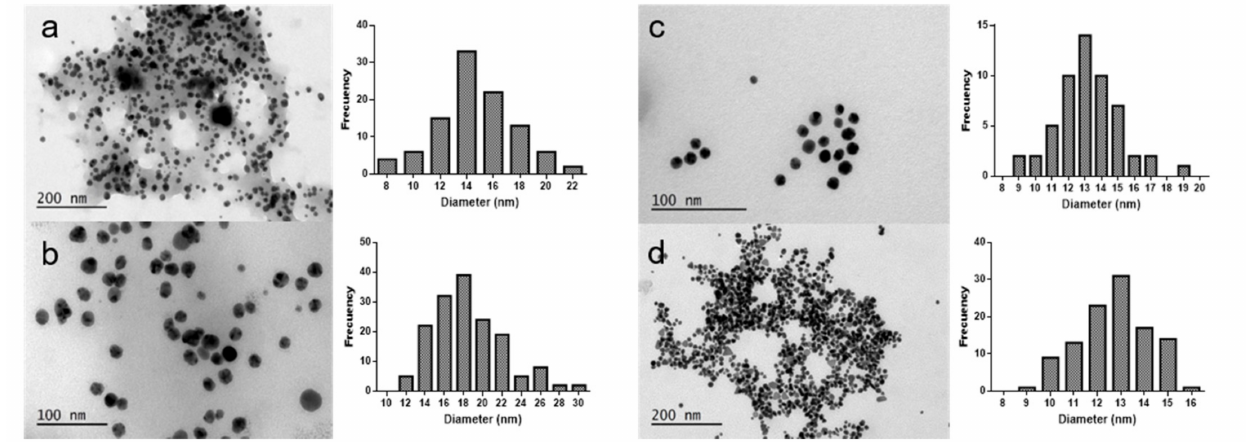
Figure 3. TEM images of ( a ) Ag@DA ( b ) Ag@IC ( c ) Au@DA, and ( d )